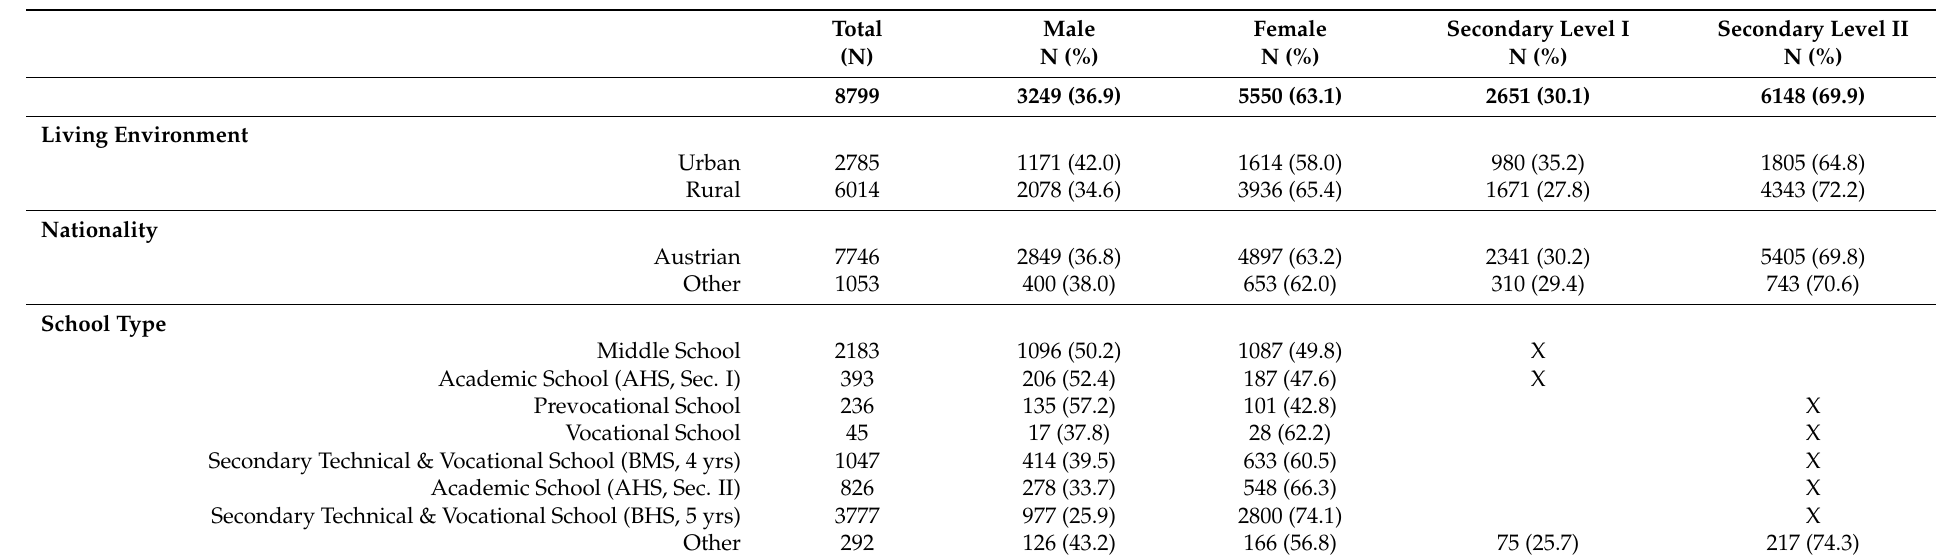
Table 1. Sample distribution. Values are the number of participants (N) and prevalence